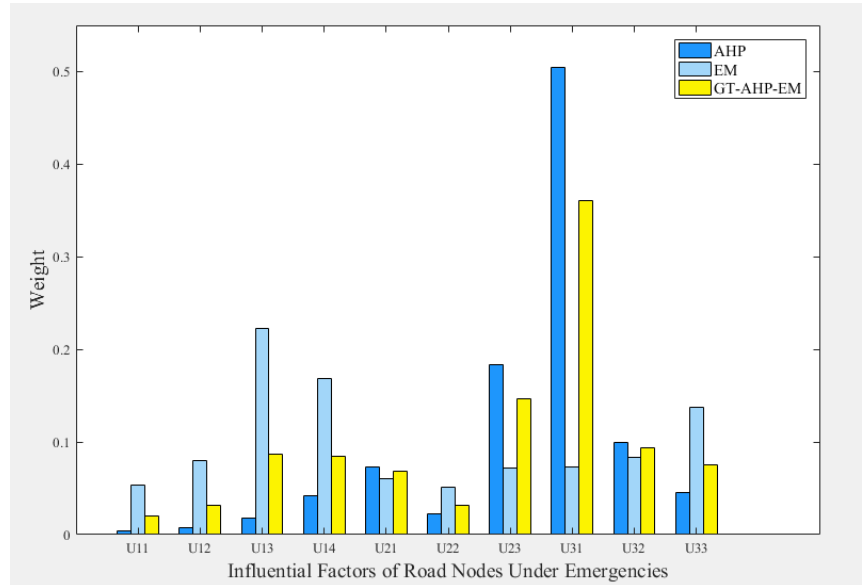
Figure 7. Comparison of the weights of traffic trend indicators calculated by 3